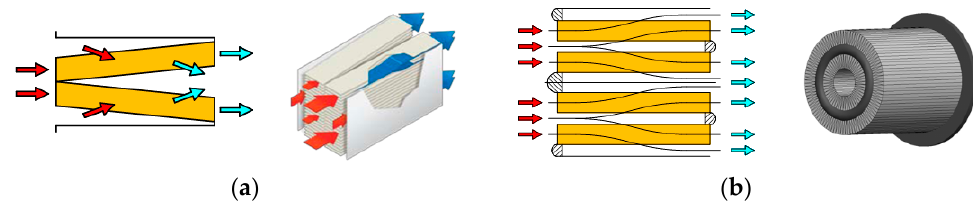
Figure 8. Principle of operation of Direct Flow filter cartridge: ( a ) panel, ( b ) cylindrical. The drawing was made by the author based on the data in [42].